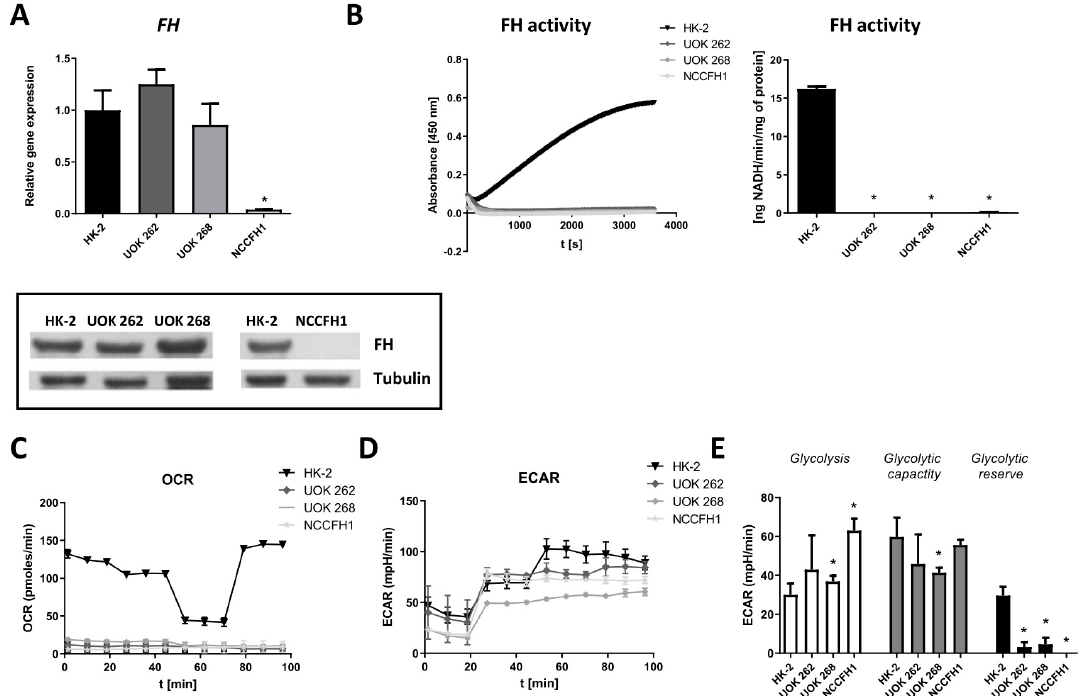
Figure 1. Characterization of fumarate hydratase (FH)-deficient cell lines. ( A ) qRT-PCR results (upper panel) and Western blot results (lower panel) for FH mRNA and protein level in UOK 262, UOK 268 and NCCFH1 cell lines in comparison to HK-2 cell lines. qRT-PCR results presented as relative fold change (mean ± SD). ( B ) FH activity in UOK 262, UOK 268, NCCFH1 and HK-2 cell lines, presented as absorbance changes over time (left panel) and ng NADH produced per minute by 1 mg protein (right panel) (mean ± SD). ( C ) Oxygen consumption rate (OCR) presented as a pmol / min and ( D ) extracellular acidification rate (ECAR) in UOK 262, UOK 268, NCCFH1, and HK-2 cell lines presented as an mpH / min. ( E ) Calculation of the typical glycolytic parameters based on Seahorse analysis: Glycolysis, glycolytic capacity, and glycolytic reserve shown as mpH / min (mean ± SD). * p < 0.05 vs. HK-2 cell line, Student’s t -test.